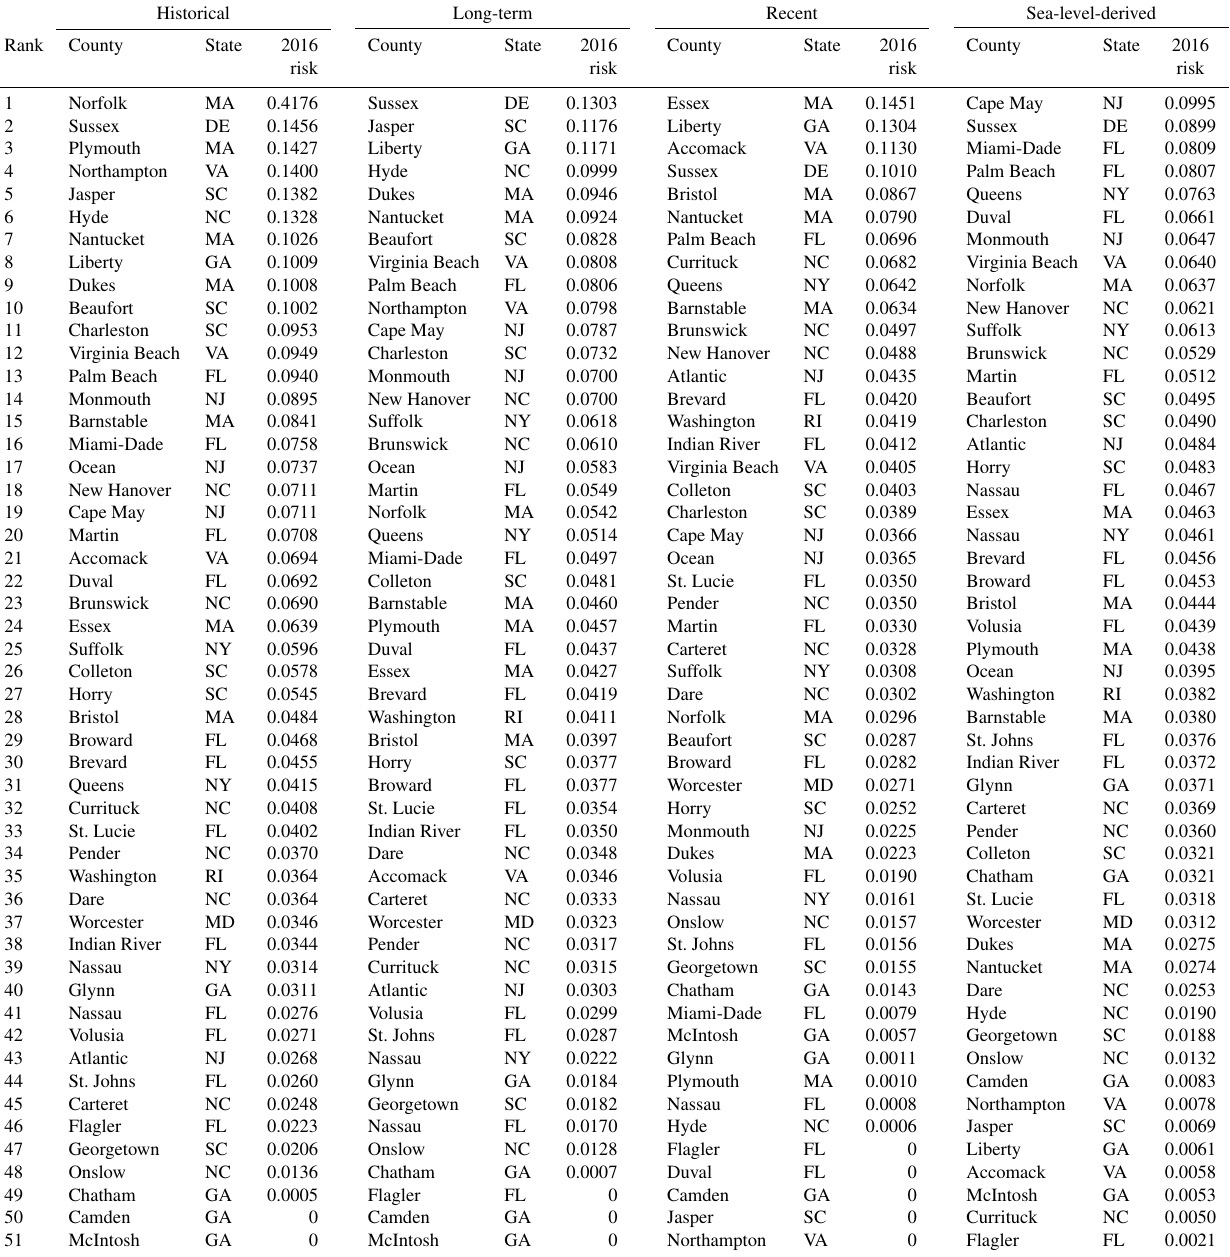
Table 1. Counties ranked by risk in 2016, calculated with historic, long-term, recent, and sea-level-derived shoreline-change rates.